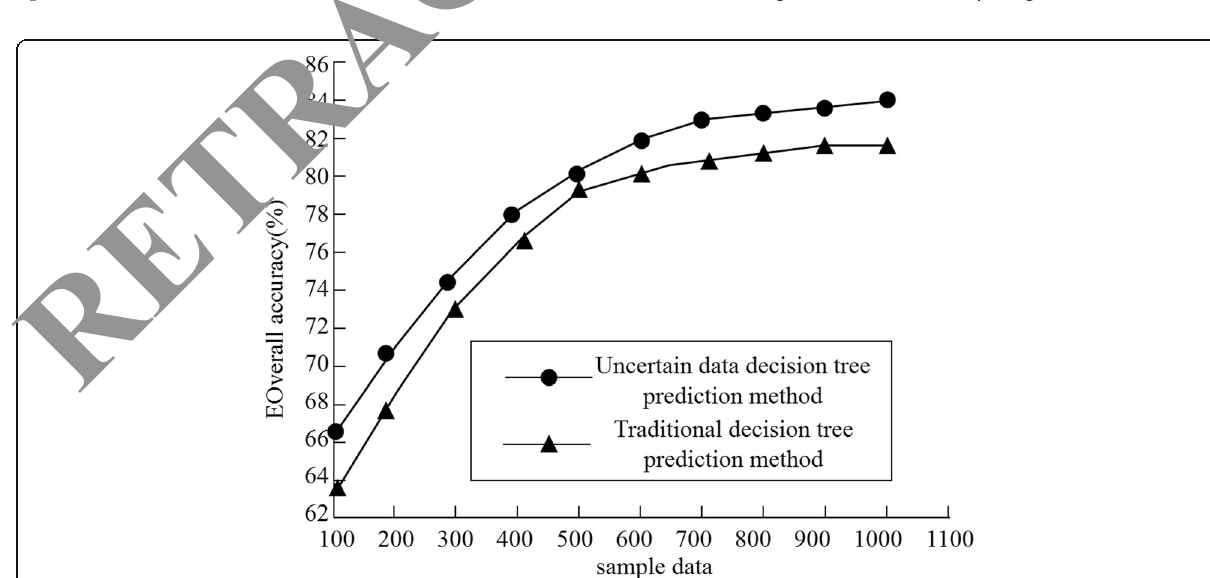
Fig. 6 Comparison of the overall accuracy of the two decision tree